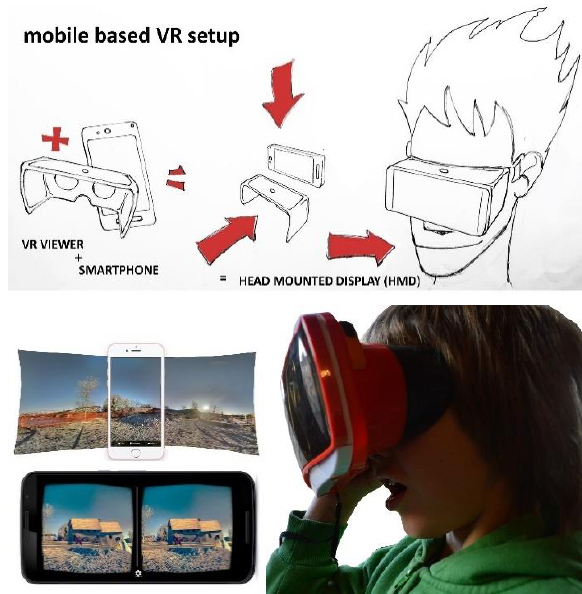
Figure 12. Above: explanation of the mobile based VR setup. Below: on the left, 360° panoramic view of the area and 3D model navigable in VR; on the right, the head mounted display for